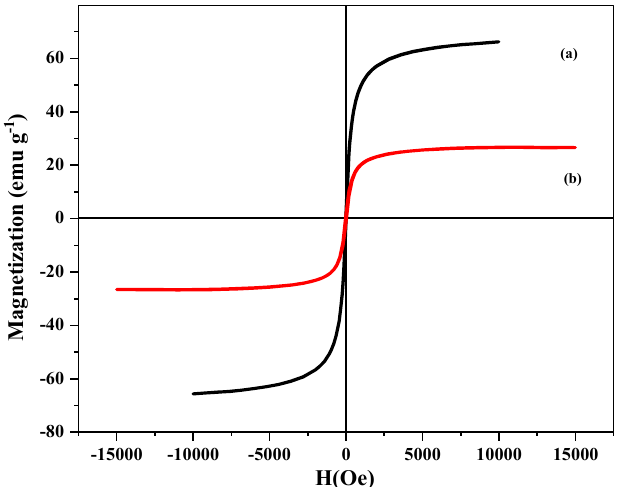
Fig. 2. Magnetization curves of (a) maghemite nanoparticles, and (b) modified pectin/ γ -Fe